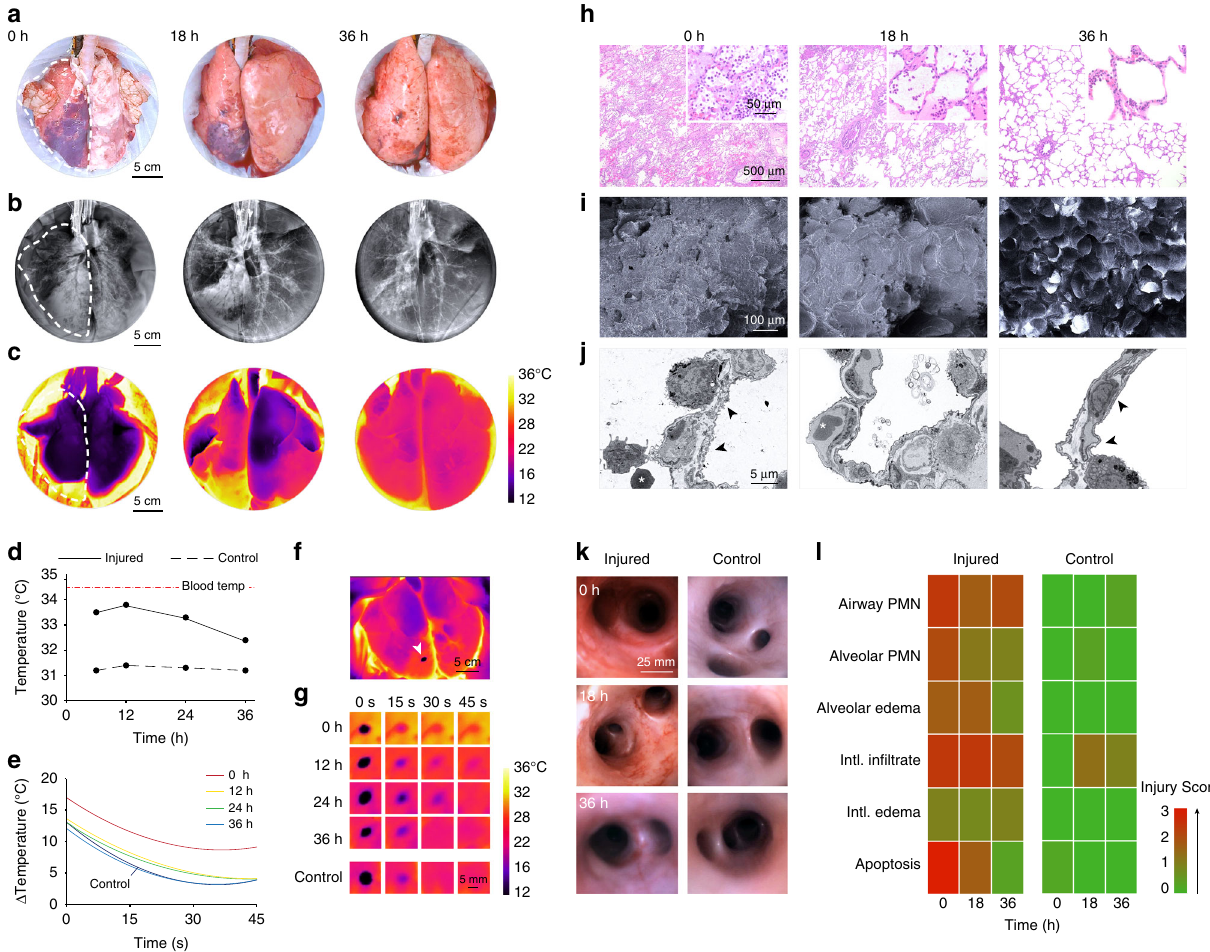
Fig. 5 Multi-scale analysis of extracorporeal lung recovery. Macroscopic appearance: a photographic, b radiographic, and c thermographic analysis of lungs throughout 36 h of cross-circulation. Dotted line indicates the injured lung. d Average recorded surface temperature of injured and control lungs throughout 36 h of cross-circulation. e Difference in temperature ( Δ ) between hypothermic lung region and average temperature of surrounding pleura over 45 s of rewarming. Surface cooling and rewarming challenge: f thermographic image of lungs following contact with a conductive hypothermic probe (arrow), and g time lapse sequence of injured and control lungs during rewarming at 0, 12, 24, and 36 h of cross-circulation. Microscopic appearance: h H&E staining, i scanning electron microscopic, and j transmission electron microscopic analysis of injured lungs throughout 36 h of cross-circulation. Type I alveolar epithelial cell membranes disrupted at 0 h and restored at 36 h (arrows). Red blood cells (stars) shown in the alveolar space at 0 h and within a capillary at 18 h. k Bronchoscopic analysis of airways in injured and control lungs throughout 36 h of cross-circulation. l Lung injury scoring of injured and control lungs at 0, 18, and 36 h of cross-circulation. All graphs represent data from n = 8 lungs. All values represent mean ± standard